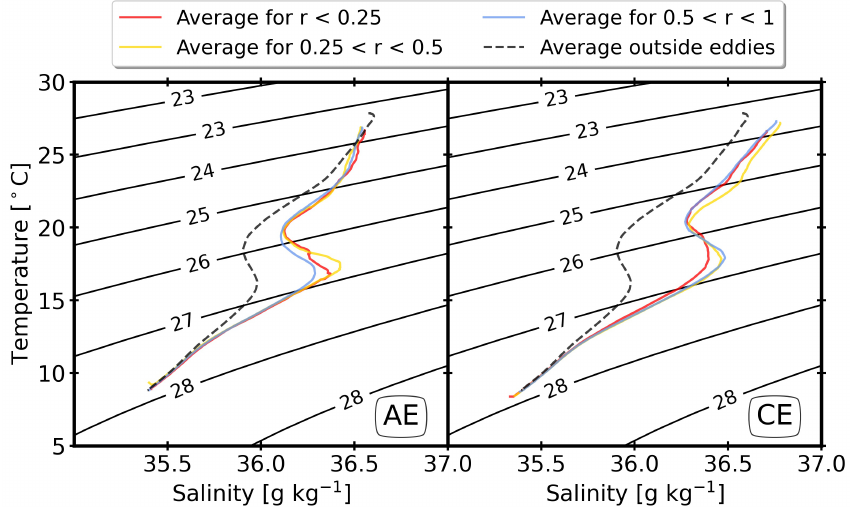
Figure 5. Averaged TS-diagram for both AE (left) and CE (right) regions; black dashed lines indicate the average outside eddies; the three colored lines indicate the respective average positions of the float to the center of the